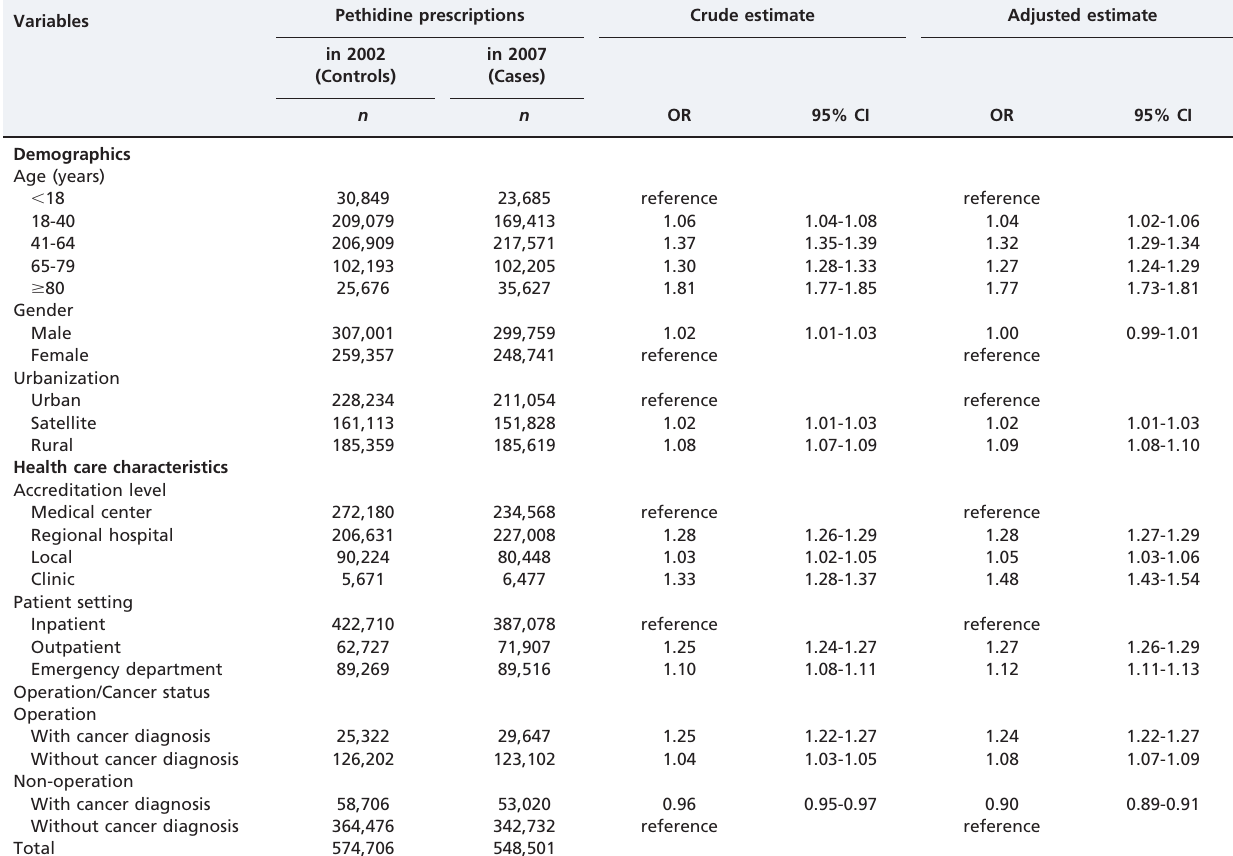
Table 4 - Comparisons of the demographics and health care characteristics of patients who received pethidine prescriptions between 2002 and